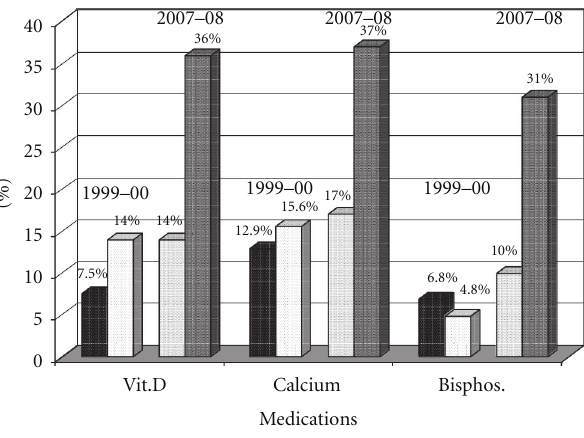
Figure 3: Medications at admission and discharge (as compared to 1999-2000